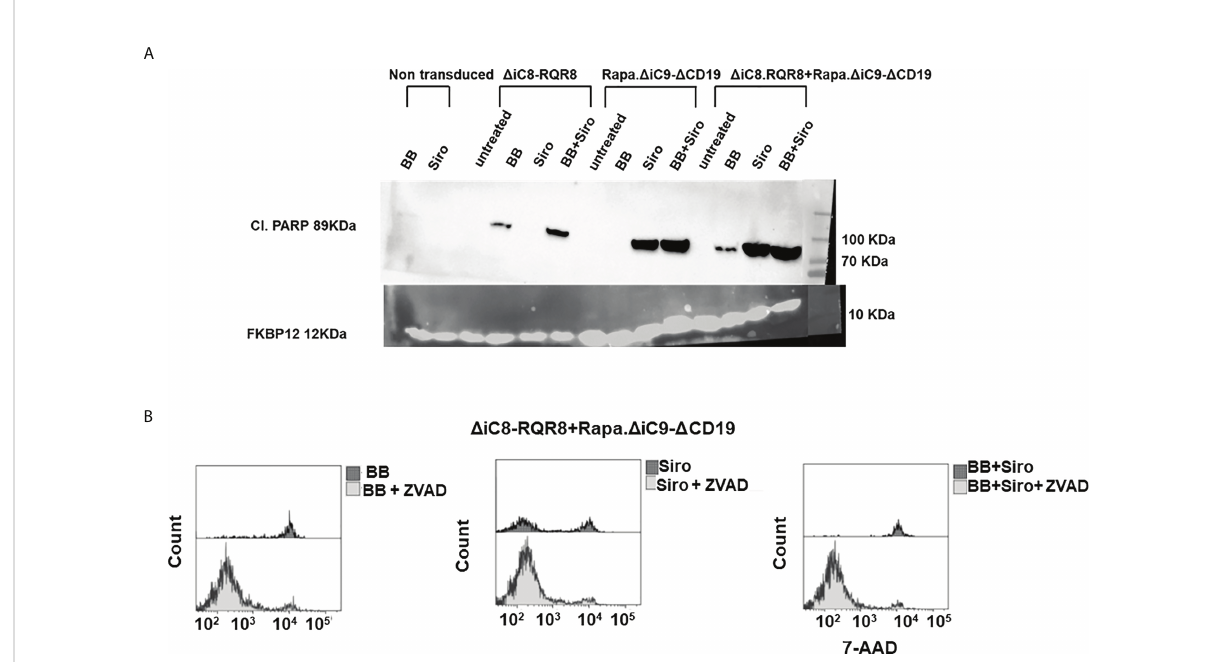
FIGURE 4 (A) Western blot for cleavage of the effector of the apoptosis Poly (ADP-ribose) polymerase (PARP), or FKBP12 endogenous control. (B) Histogram depicting viable D iC8-RQR8/Rapa. D iC9- D CD19 Jurkat cells after administering the BB homodimerizer, sirolimus (siro) or both in the absence or presence of the ZVAD fmk pan-caspases